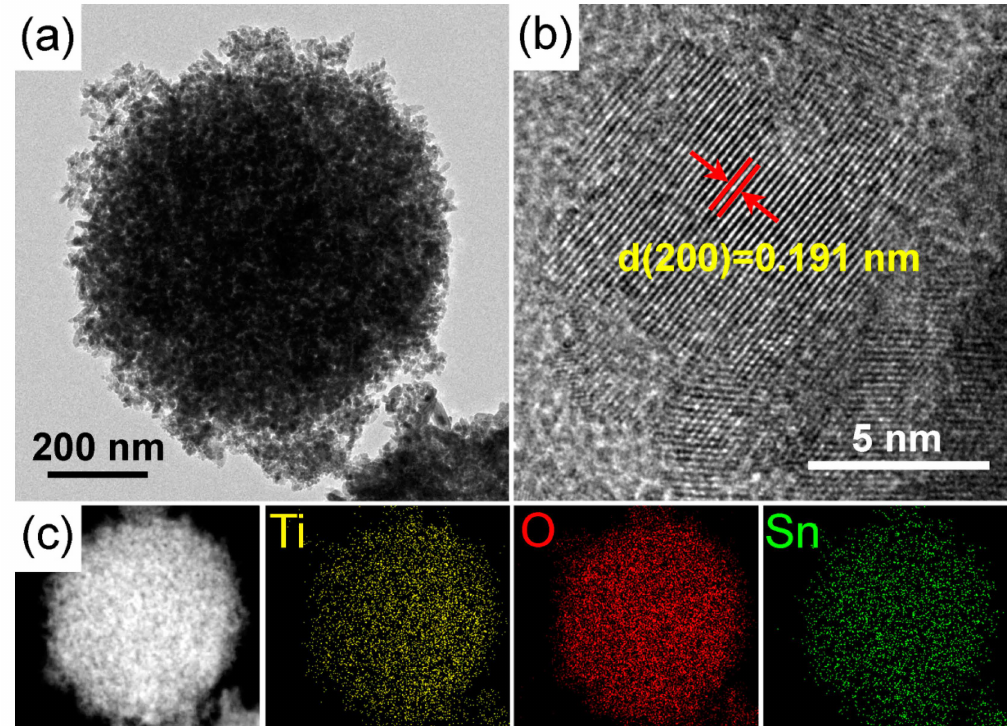
Figure 8. ( a ) TEM and ( b ) HRTEM images of an STO hierarchical nanosphere with a 5% molar ratio of n Sn / n Ti . ( c ) The scanning transmission electron micrograph (STEM) images and corresponding STEM-EDX elemental mapping of an STO hierarchical